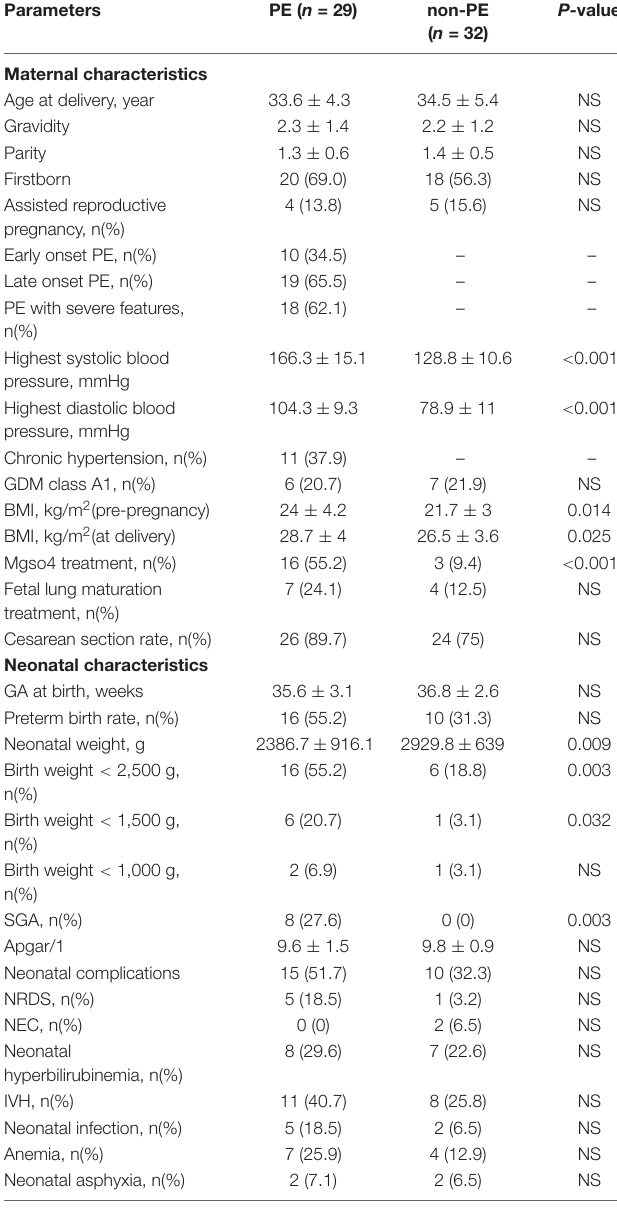
TABLE 1 | Demographic and clinical characteristics of the mother and baby: PE vs. non-PE groups.